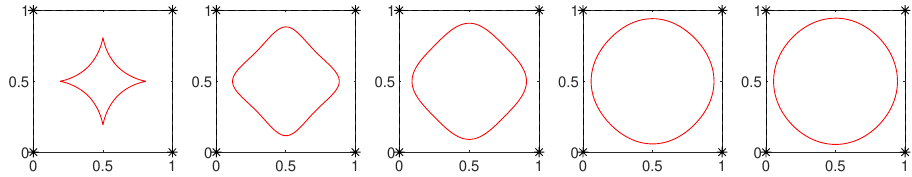
Figure 5. Curves generated by the scheme { S a k } k ≥ 0 with v 0 = − 0.35 and β = 2,1.2,0.8, 0.1,0 (from left to